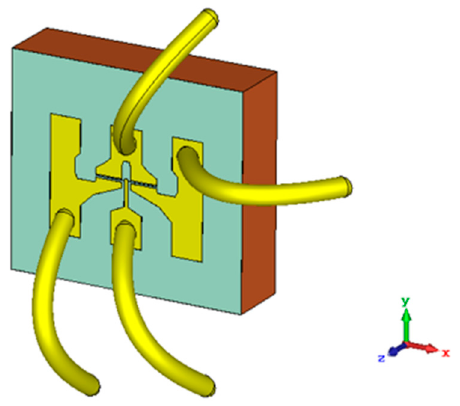
Figure 6. Spatial distributions of the module of the normalized electric field inside the transistor channel under illumination at 0.15 THz, ( a ), and 0.30 THz. ( b ) The maximum values of the normalized electric field inside the channel are 10.56 dB and 20.41 dB for excitation at 0.15 and 0.30 THz, respectively, as displayed in Tables 1 and 2. Black solid lines indicate the contour of the top side transistor electrodes and are a guide to the eye.